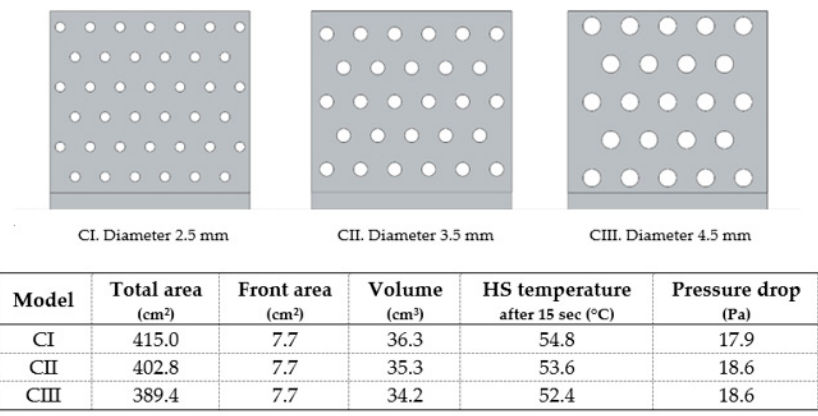
Figure 9. Model C variants.